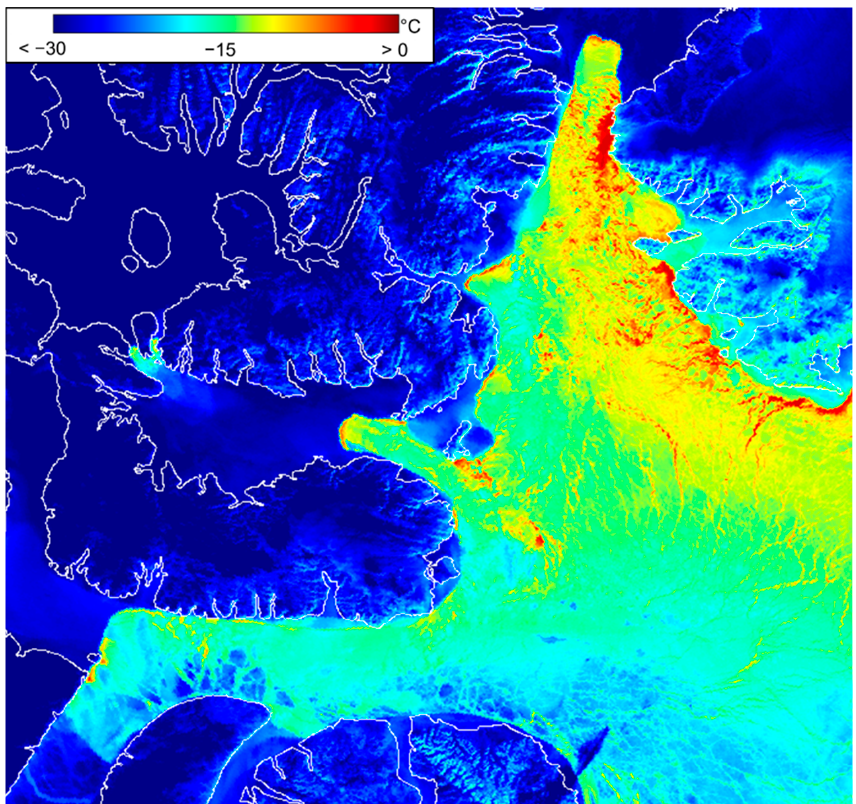
Figure 11. CASSTA mapping of the NOW, Jones Sound and Lancaster Sound polynyas with coastlines outlined for 4 Apr 2016. Surface temperatures in Lancaster Sound are well below the freezing point of seawater, implying that the increased temperature is the result of thermal contribution to the pixel by sub-resolution leads. Warmer temperatures are indicative of reduced ice cover, but there are no large regions of open water. This was typical of Lancaster Sound during the colder months. The image also shows that the eastward outflow of ice from the Lancaster Sound polynya is influenced by ice conditions in northwestern Baffin Bay owing to the southward moving floes from the NOW and Jones Sound.